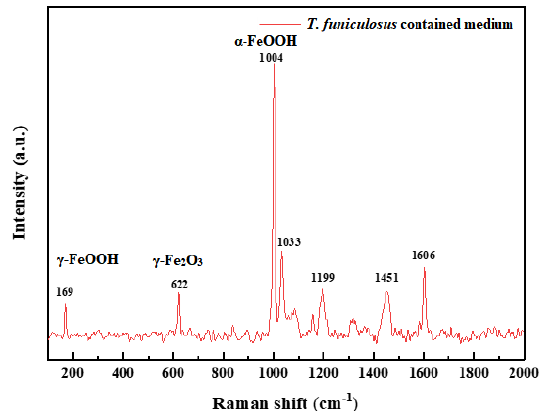
Figure 13. Raman spectra of corrosion products on the electrode after the immersion in the T. funiculosus -contained medium for 14 days.